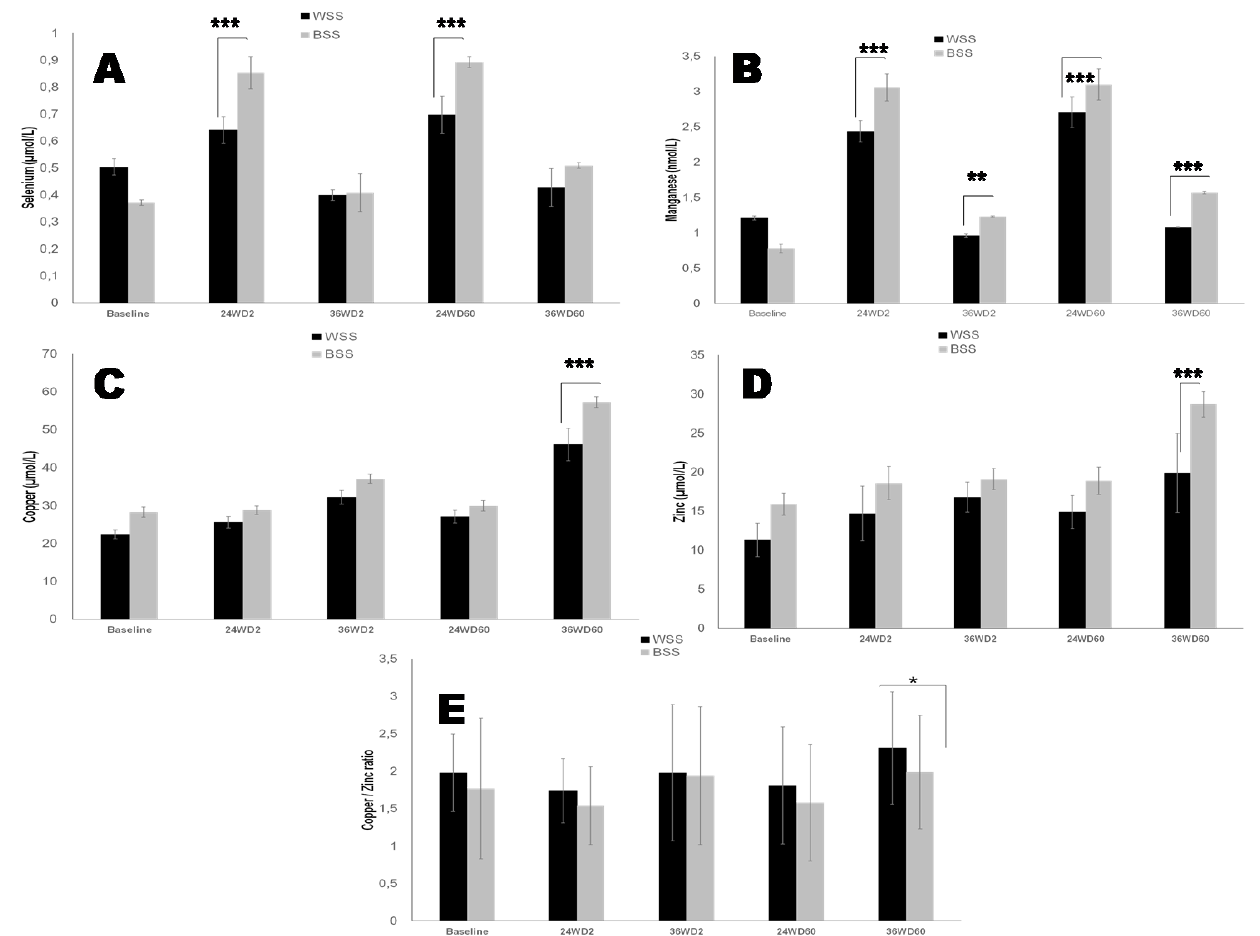
Figure 5. Effects of oral 2000 IU/day and 60,000 IU/month vitamin D 3 supplementation on serum trace elements profile in Black versus White SS CKD participants. ( A ): Selenium; ( B ): Manganese; ( C ): Copper; ( D ): Zinc; ( E ): Copper–Zinc ratio. The mean values are assigned from the standard error to the mean (X ± ESM). The degree of significance is calculated for a risk of error α = 5%. The mean comparison is established for each group, White SS and Black SS. Baseline data were obtained before vitamin D supplementation. p -value is calculated at baseline time (White SS versus Black SS groups). * p < 0.05; ** p < 0.01; *** p <